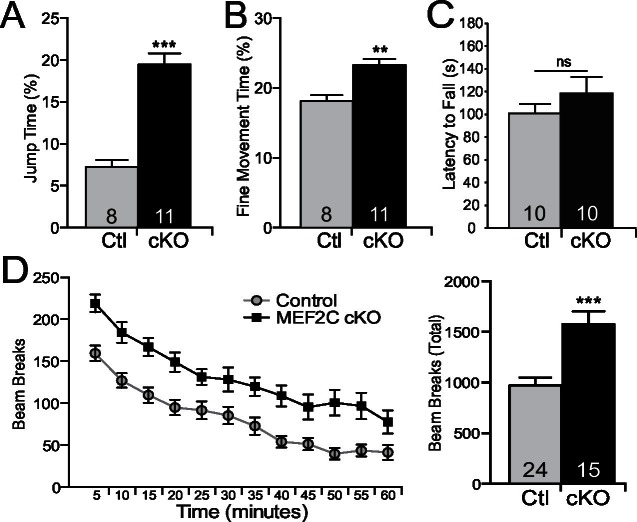
Repetitive behaviors and hyperactivity in Mef2c cKO mice.(A) Mef2c cKO mice spend more time jumping than control animals in an operant chamber over a 1-hr interval. (B) Mef2c cKO mice have more fine motor movements in an operant chamber, reflective of stereotypic activity. (C) Latency to fall off an accelerating rotarod is not different in the Mef2c cKO mice. (D) Mef2c cKO mice are hyperactive compared to control littermates. Activity was monitored for 1 hr, and data is plotted by beam breaks/5 min (left) and cumulative beam breaks (right). Data are represented as mean ± SEM. Statistical significance was determined by unpaired t-test (A–D) or 2-way ANOVA (D). **p<0.005, ***p<0.0005, ns=not significant. Numbers of animals (n) are reported in each bar for respective experiment.